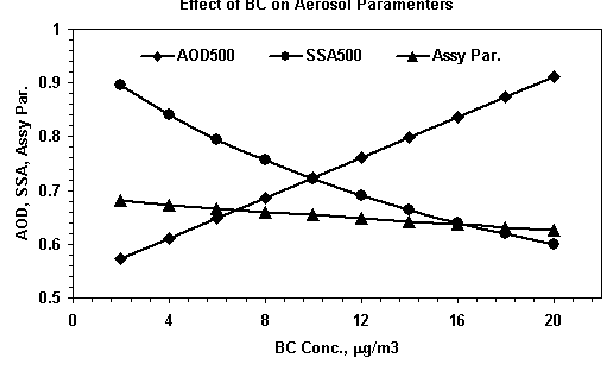
Fig. 6. Variation of single scattering albedo with wavelength as estimated using OPAC model during typical months in different seasons over Delhi.